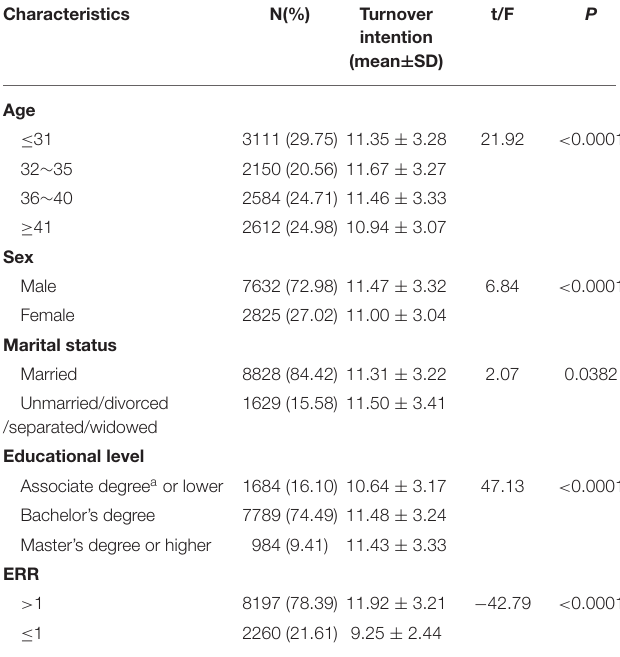
TABLE 1 | Demographic characteristics of the participants ( N = 10457). Characteristics